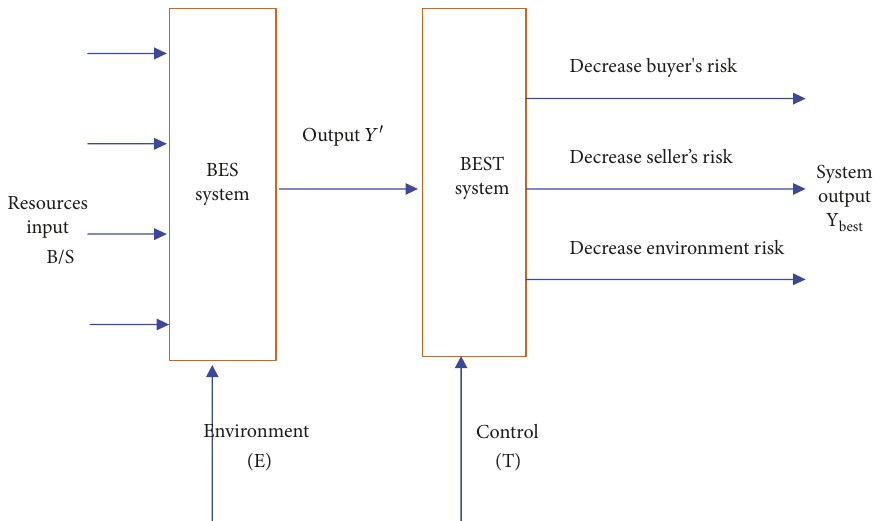
Figure 1: The mechanism of BEST control and management system.